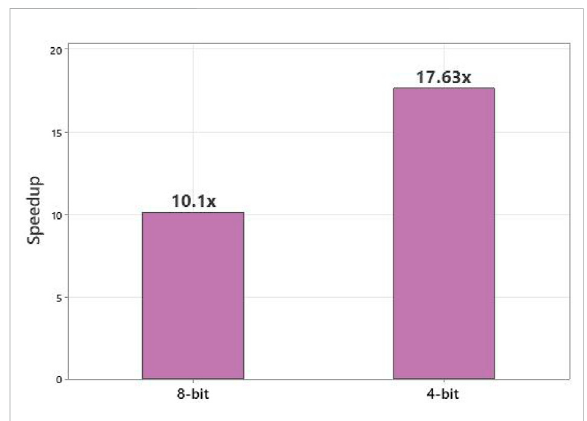
FIGURE 8 Performance improvement of AI-PiM for GEMV kernel compared to RV64IMC baseline. Results for 64 × 64 bit PiM functional unit used in two different con fi gurations are shown